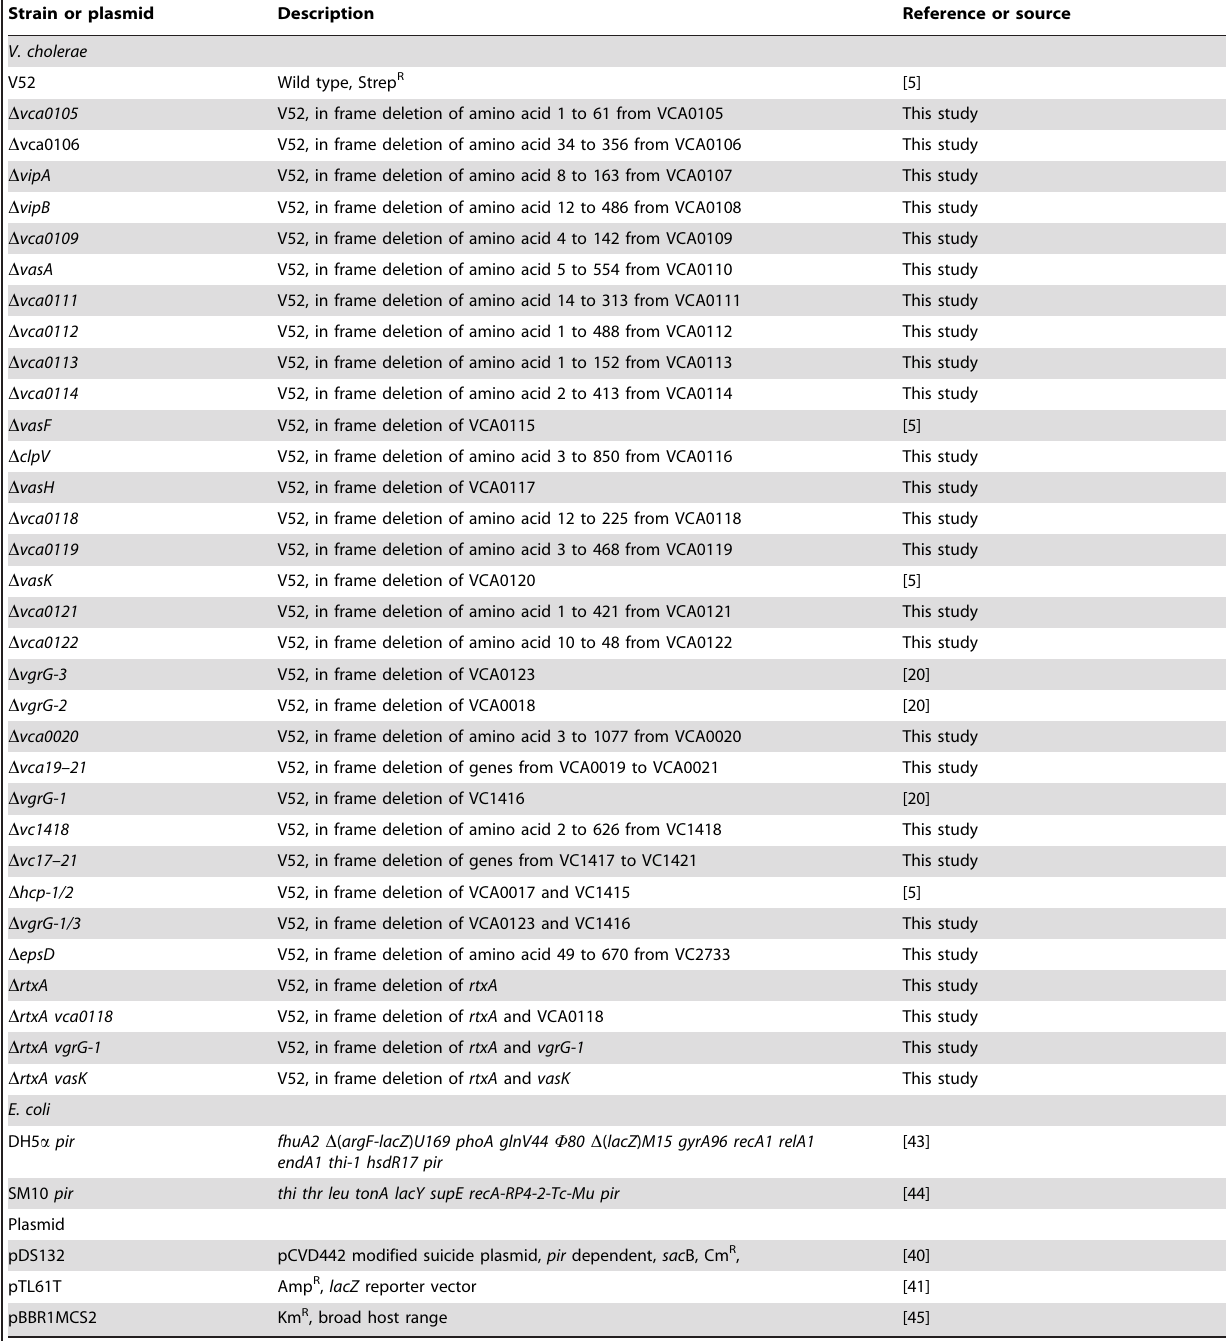
Table 2. Strains and plasmids for this